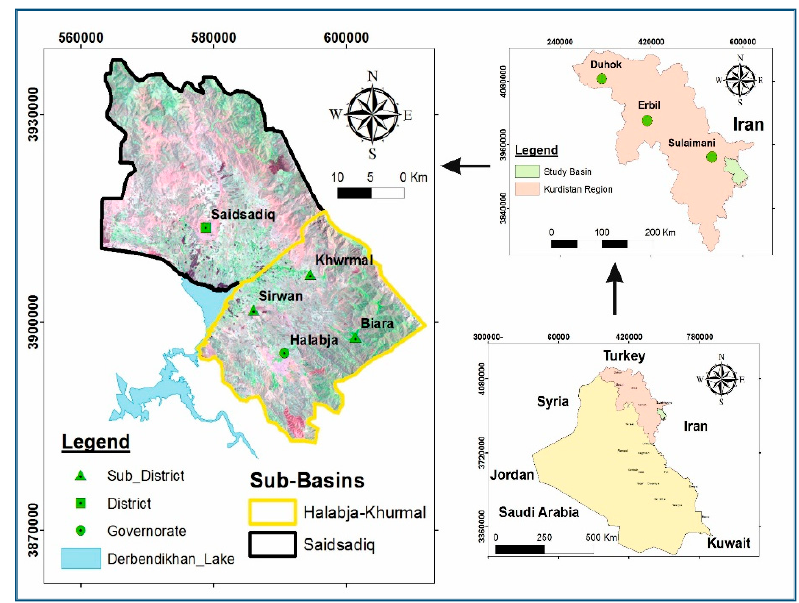
Figure 1. Site map of the Halabja Saidsadiq Basin (HSB) [16].